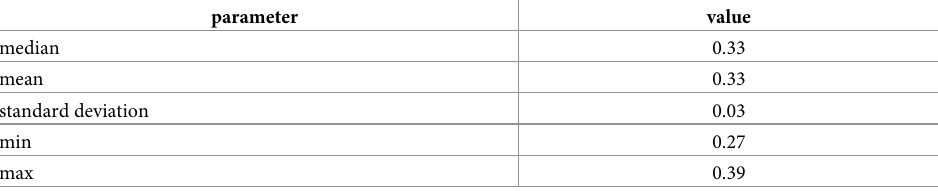
Table 2. Distribution of σ value for 21 non-atrophic optic